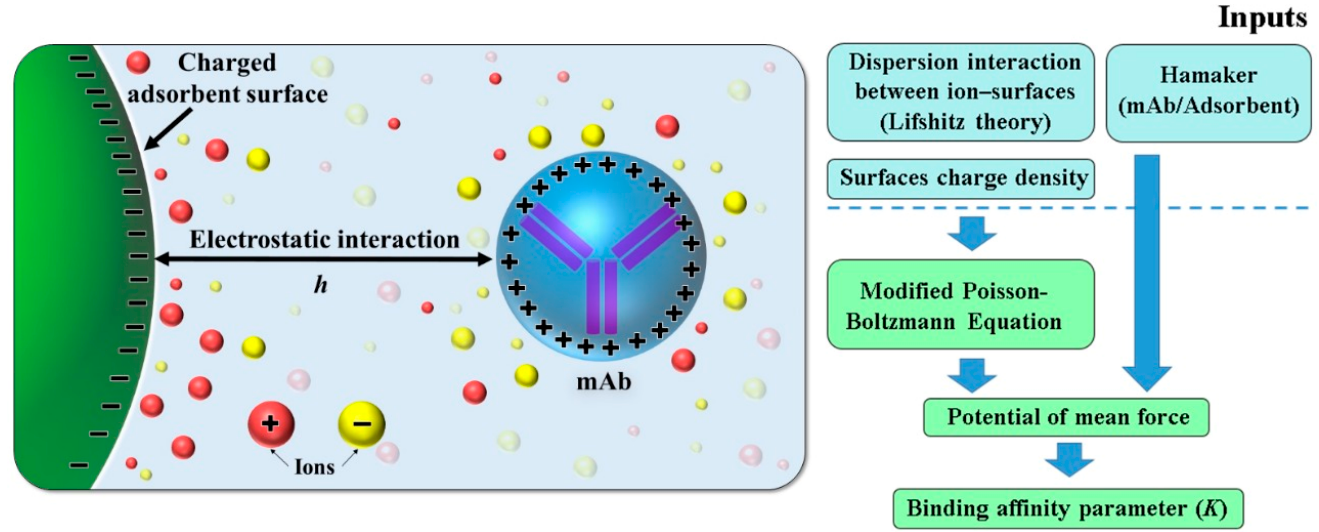
Figure 1. Schematical representation of the antibody adsorption by ion-exchange.